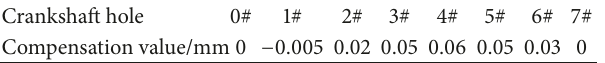
Figure 5: The simulation model of virtual manufacturing.